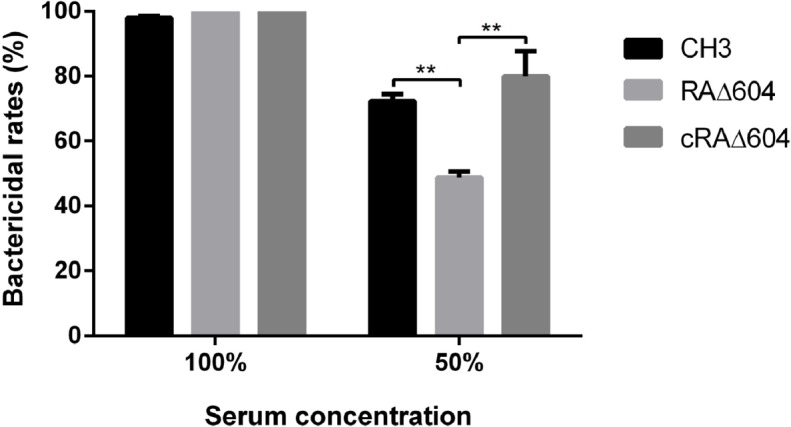
Serum bactericidal experiment.Bacteria were incubated with pooled normal duck sera at 50% dilution or without dilution at 37°C for 30 min. The heat-inactivated pooled duck sera were used as a control. The mutant strain RAΔ604 displayed significantly greater resistance to normal duck serum as compared to the WT and cRAΔ604 strains. The error bars represent mean ± standard deviations from three independent experiments (**, p < 0.05).